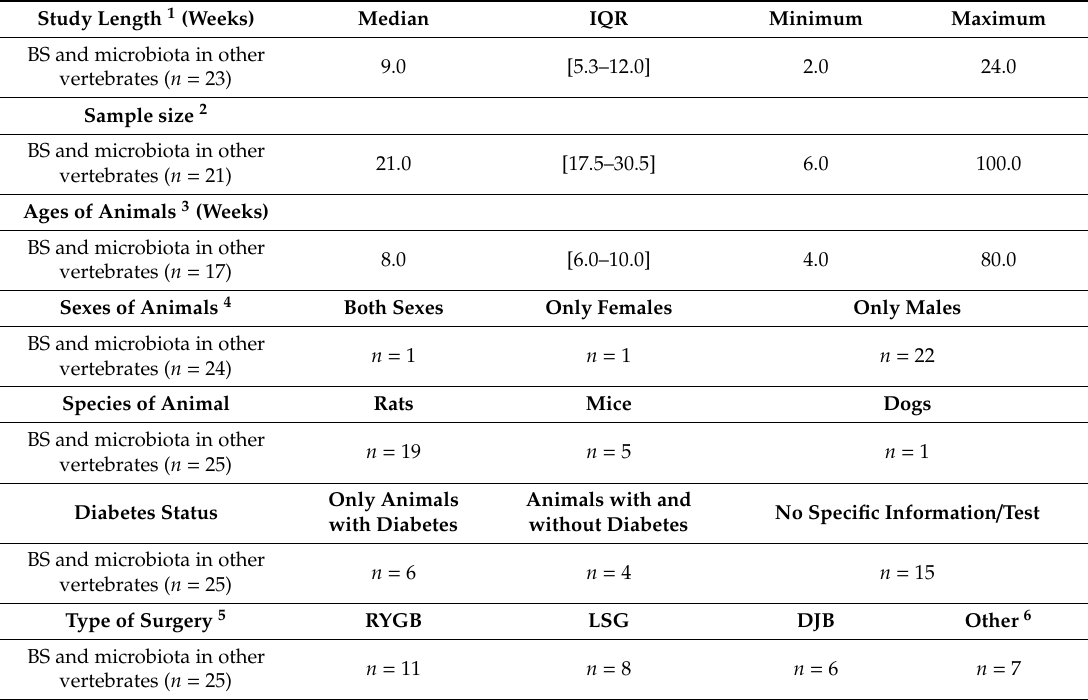
Table 2. Characteristics across other vertebrates’ studies—Group